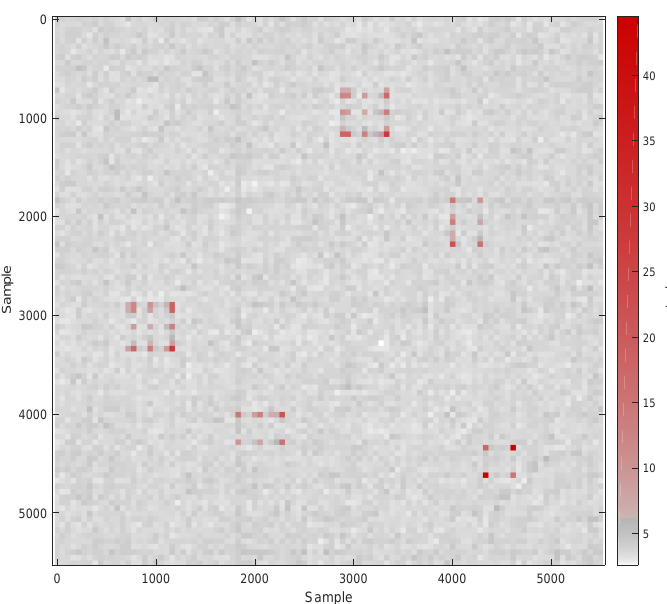
Figure 4: Second-order leakage for two-share version with four coefficients (masks enabled, 1 M measurements, t th = 6 . 28). Points with t -values above the threshold are highlighted